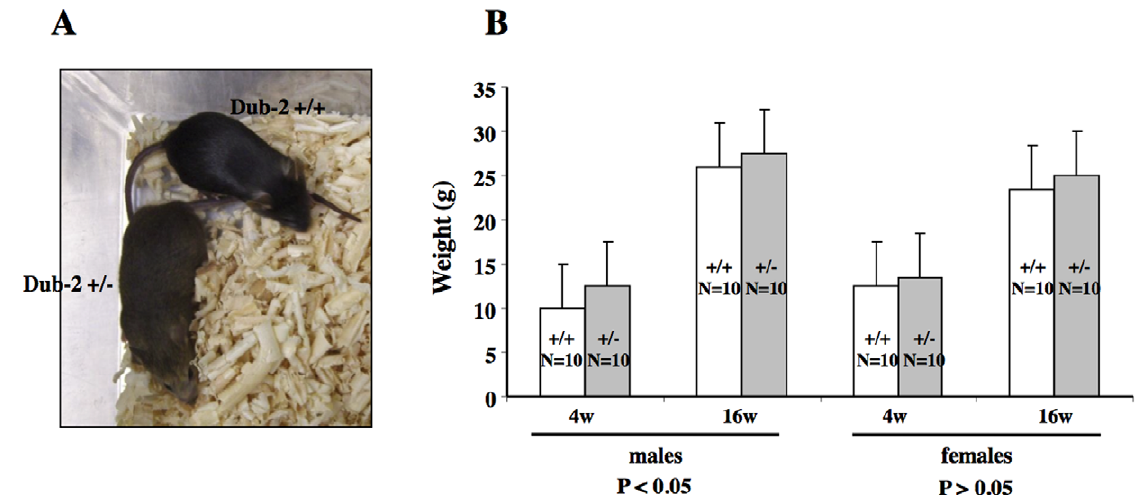
Figure 2. The phenotypes of Dub-2 -deficient mice. A) Representative 8 week old mice of the indicated genotype demonstrating a size difference in heterozygous males. B) Mice of the indicated genotype were weighed at the indicate ages in weeks. C) The weight of ovary, testis, thymus, and spleen was measured. While there is no difference for the ovary, statistically significant difference was observed for the testis. The weight of the thymus in Dub-2 + / 2 is heavier than that of Dub-2 + / + mice. doi:10.1371/journal.pone.0044223.g002 different pro- and anti-apoptotic molecules associated with DUBs process of cell death [39]. Recent studies on HAUSP/Usp7 knock- that are disturbed during early embryonic development. Several out mice also showed similar embryonic lethality during early evidences show that germ cells and germ cell tumors signal for the embryonic development and died between embryonic days E6.5